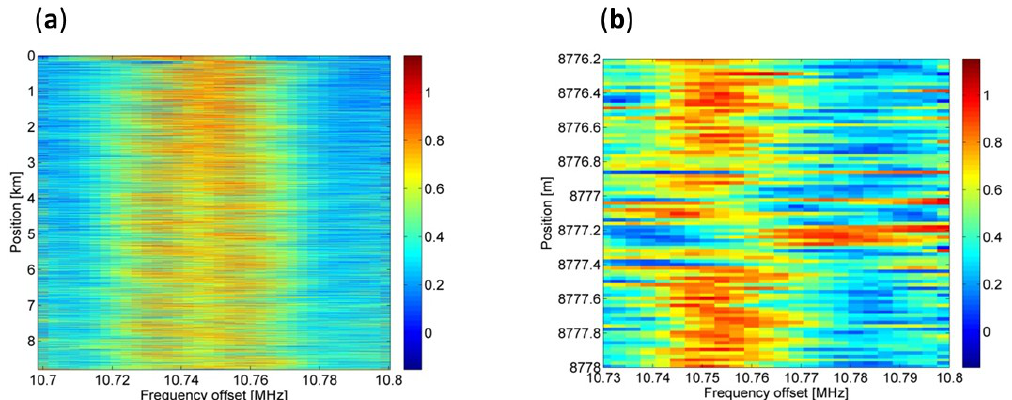
Figure 6. ( a ) Measured normalized Brillouin gain as a function of correlation peak position and frequency offset between the pump and signal waves [19]. The fiber under test was 8.8 km long. Measurements were performed with a spatial resolution of 2 cm. All 440,000 resolution points were successfully addressed. The Brillouin pump and signal waves were jointly phase-modulated by a repeating perfect Golomb code of 211 symbols period and a bit duration of 200 ps. The pump wave was also amplitude-modulated by a sequence of 9785 pulses with symbol duration of 20 ns. ( b ) Magnified view of the Brillouin gain map in a 2-m-long section located towards the output end of the fiber under test [19]. A 7-cm-long heated region is identified by the Brillouin analysis. Reproduced with permission from [19], IEEE, 2016